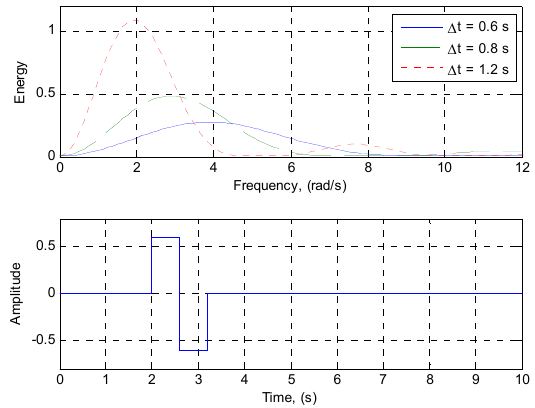
Figure 2. Doublet input with different time steps.